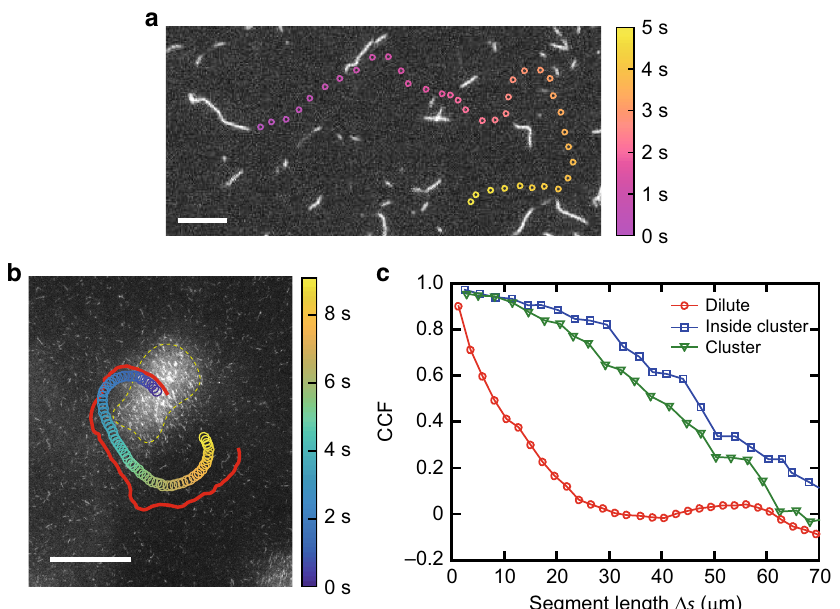
Fig. 5 Orientational decorrelation of fi lament trajectories. a Typical trajectory of a single fi lament in a dilute condition ( ρ = 0.03 fi laments μ m − 2 ), de fi ned by the head of the fi lament. Scale bar: 2 μ m. b Time trace of a fi lament head trajectory inside a polar ordered cluster ( red solid line ), and the centre of the cluster itself ( open circles ), at fi lament density ρ = 5.9 fi laments μ m − 2 . The cluster is indicated by a yellow dashed line . Scale bar: 50 μ m. ( c ) Cosine correlation function (CCF) as a function of segment length Δ s (travelled distance) for single fi laments in a dilute condition ( ρ = 0.03 fi laments μ m − 2 : red open circles ), inside a cluster ( blue open squares ) and that of clusters themselves ( green open downward triangles ). The persistence of the fi lament motion inside a cluster is greatly enhanced compared to those in a dilute bath of fi laments. Here, N Dilute = 38, N Inside = 21 and N Cluster =